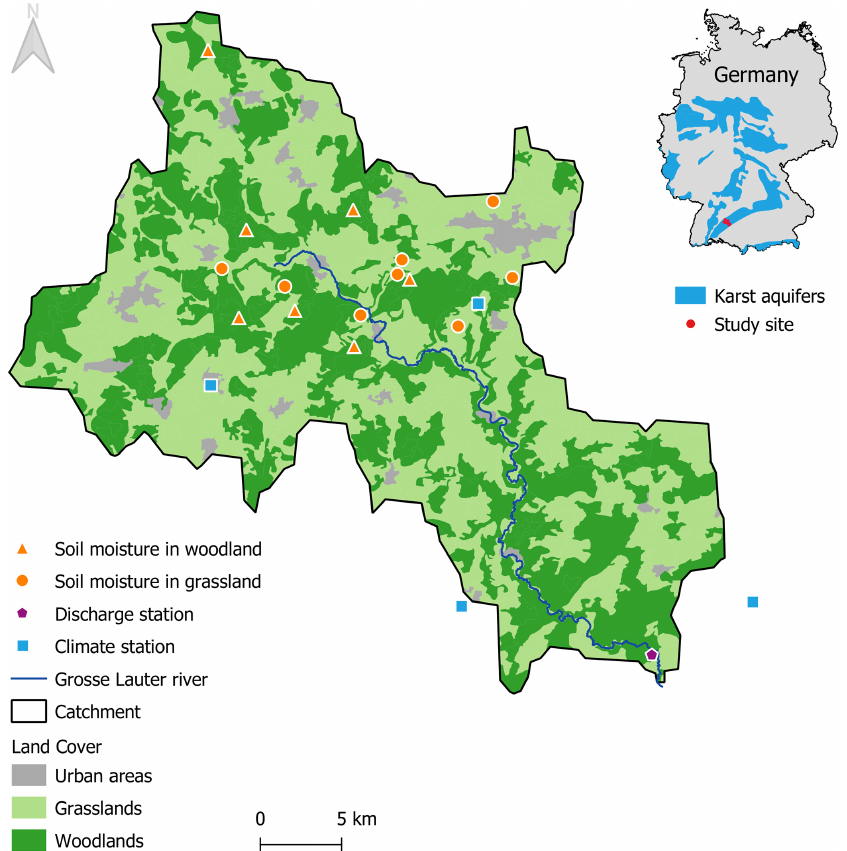
Figure 4. Map of the Große Lauter catchment with the location of the soil moisture profiles, the discharge gauging station, and the four climate stations. (Land cover: Corine Land Cover CLC (2018) modified. Karst aquifers: Chen et al., 2017).